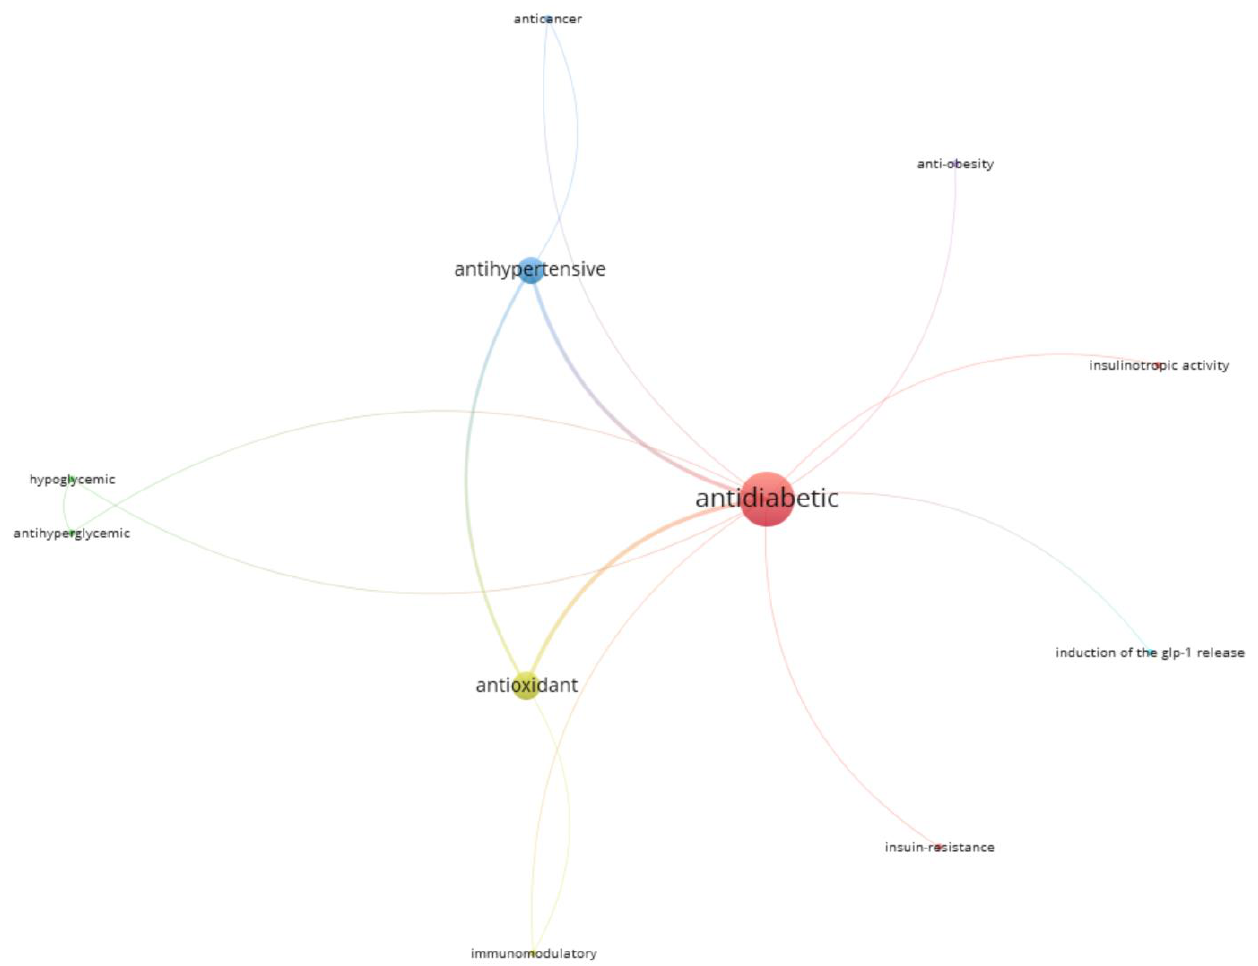
Figure 5. Network visualization map of the studied bioactive peptides with multifunctional activities. Node size is proportional to the number of occurrences (VOSviewer).